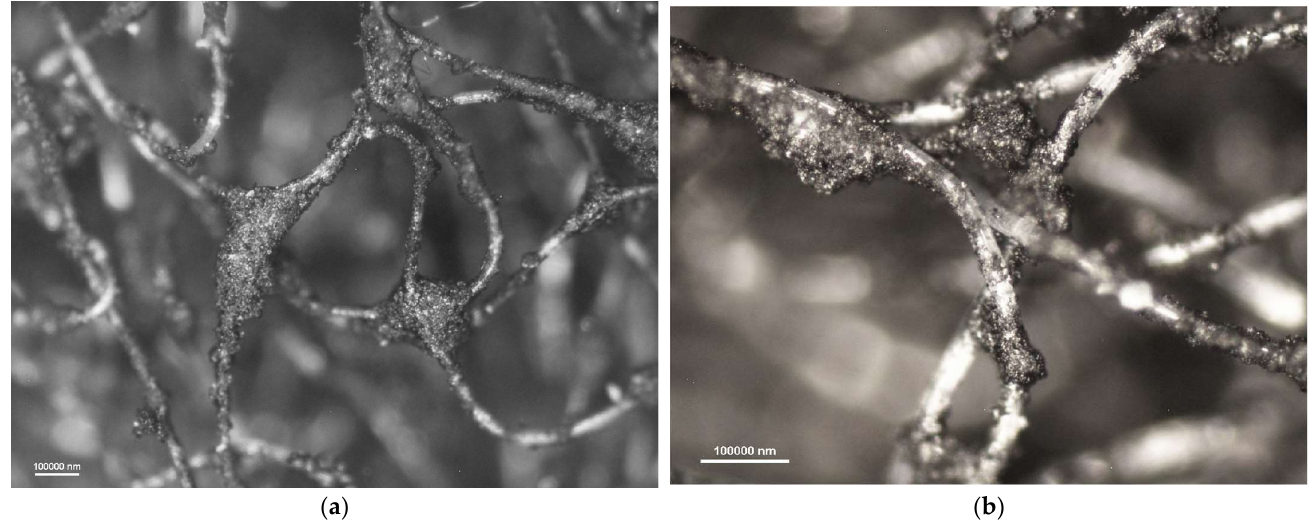
Figure 9. Photomicrographs of adsorbing nonwoven from half-mask 4 at a magnification of ( a ) ×50 and ( b ) ×100 .